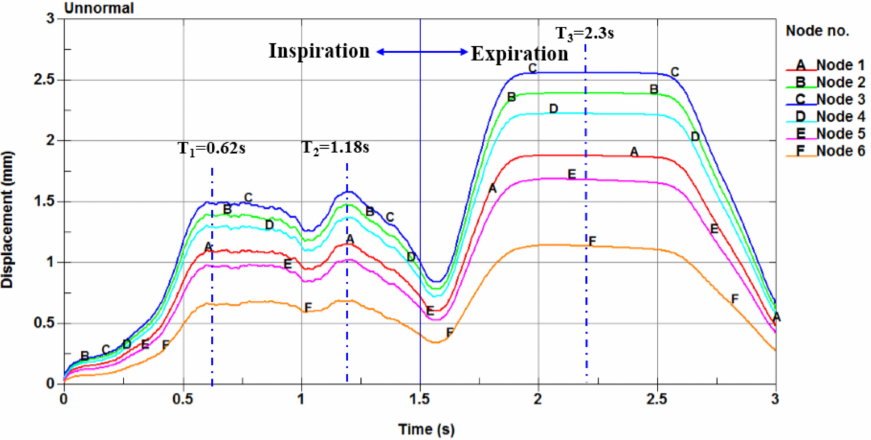
Figure 7. The displacement versus time curves of the six nodes in the soft palate of the OSAHS patient under apnea.